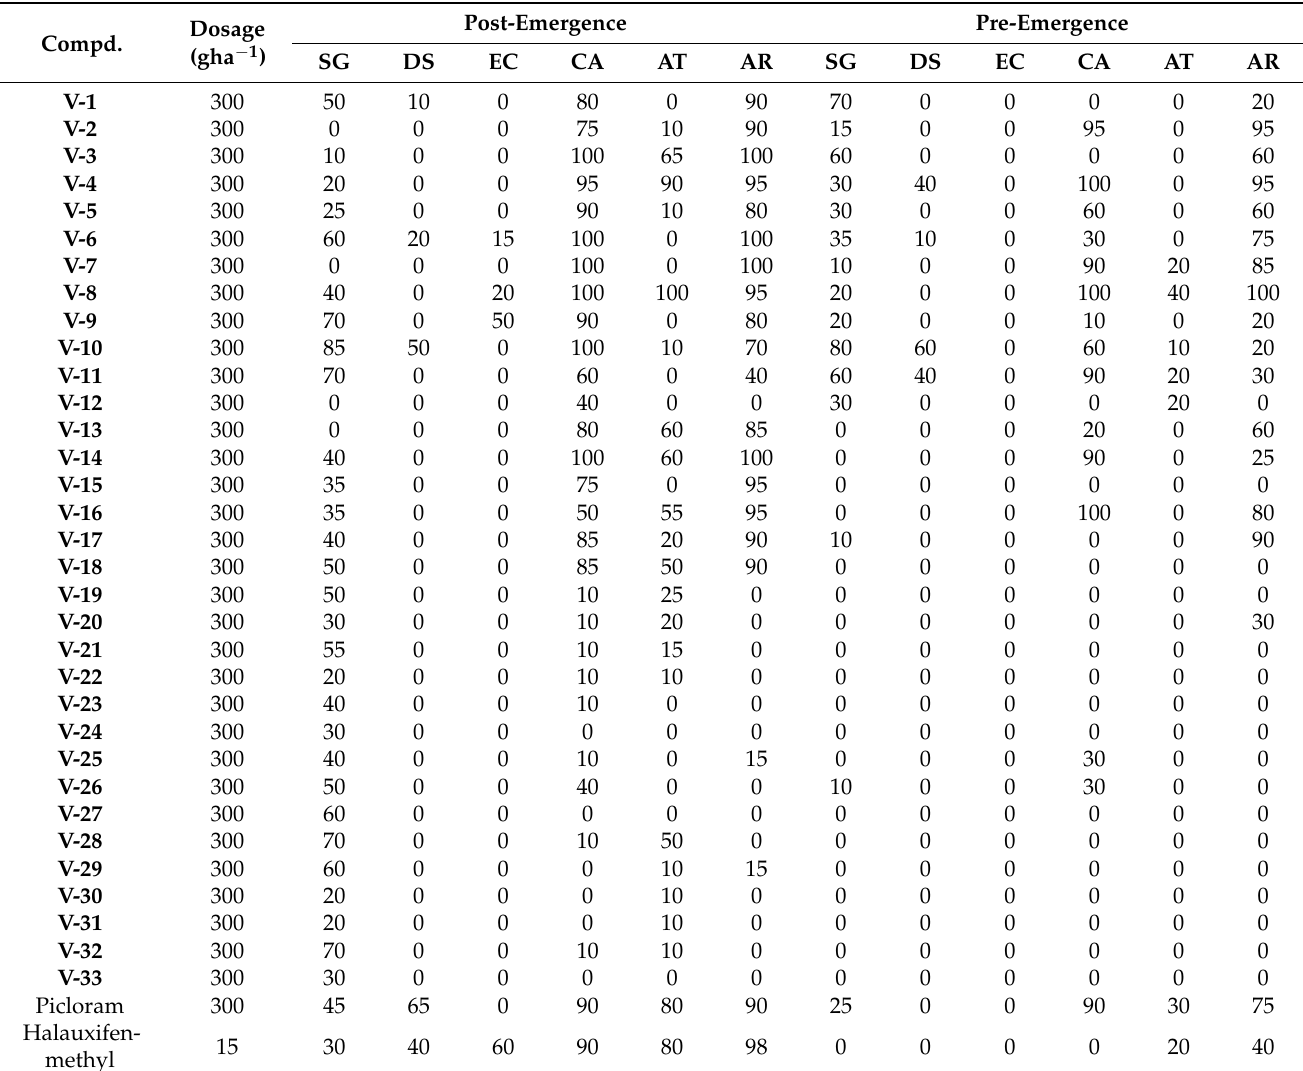
Table 4. Herbicidal activities of all compounds.